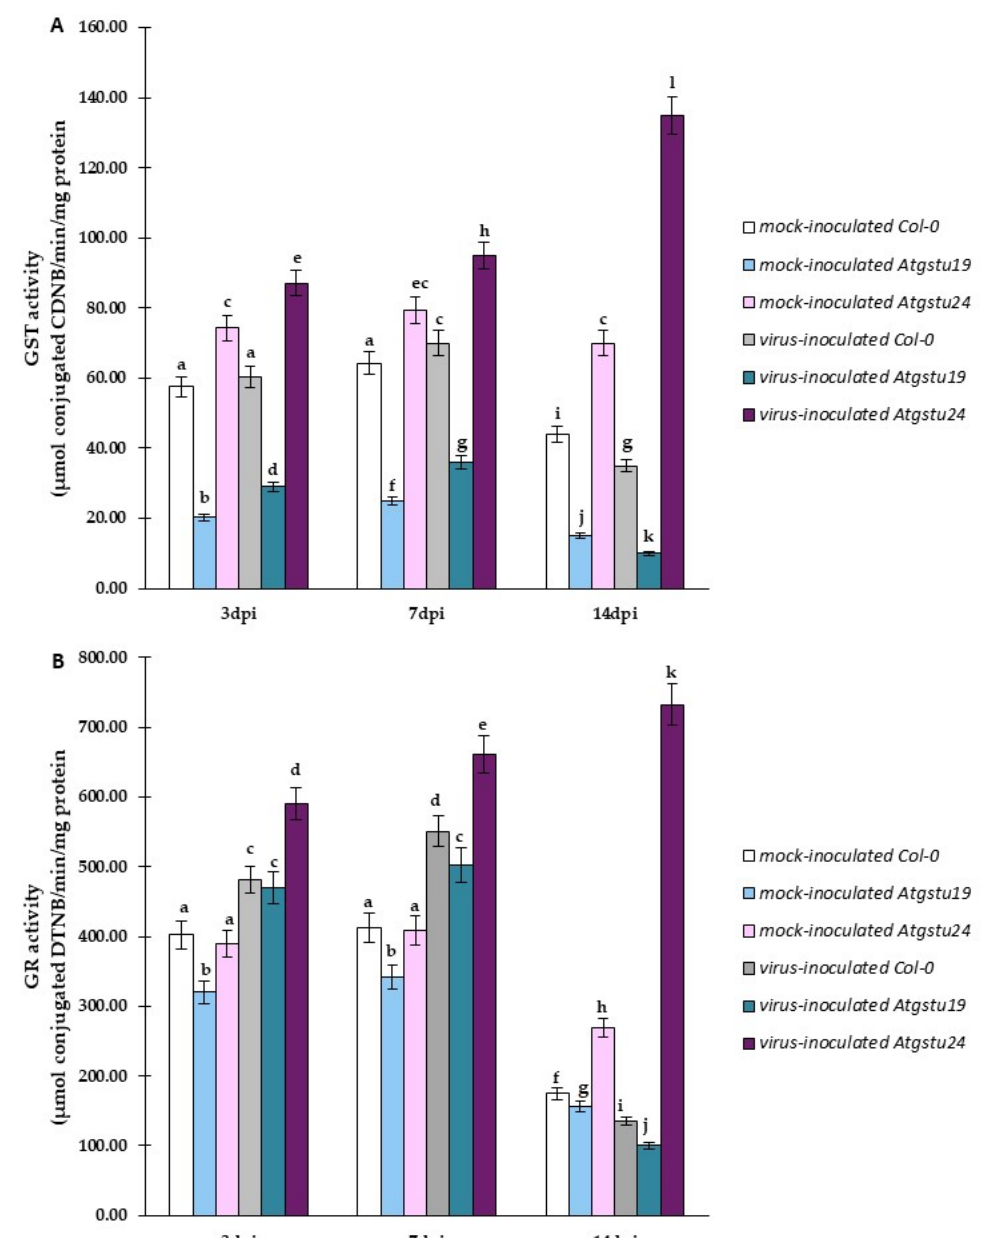
Figure 10. GST ( A ) (in nanomoles of conjugated CDNB) and GR ( B ) (in nanomoles of conjugated DTNB) activities in the leaves of TuMV- and mock-inoculated Col-0, Atgstu19 , and Atgstu24 plants between 3 and 14 dpi. The mean activities were calculated using ANOVA and Tukey’s HSD test at p < 0.05. Statistically significant values are indicated by letters above the bars.